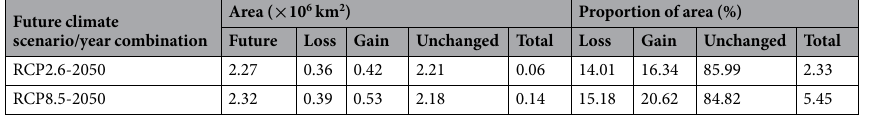
Table 3. Changes in suitable areas for P . ostii under two future climate scenario/year combinations RCP2.6- 2050 and